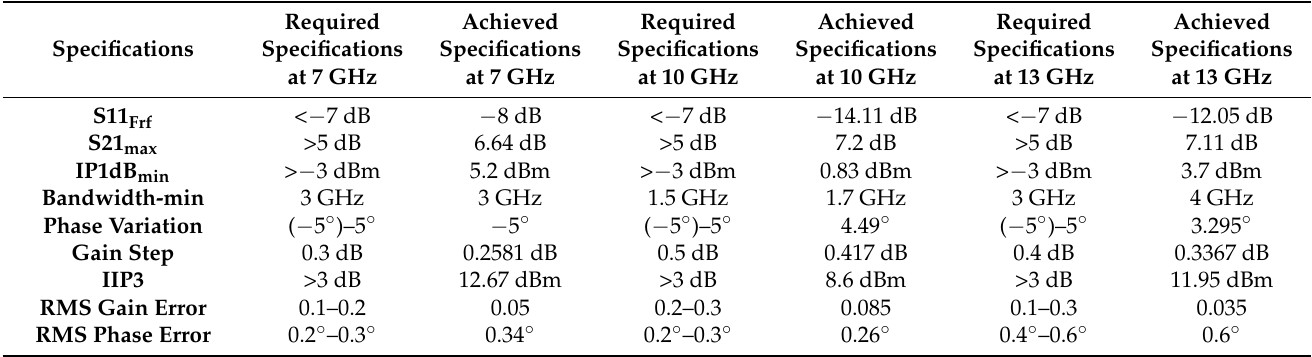
Table 4. Comparison between the achieved specifications from the proposed tool at the three test frequencies and the required ones.